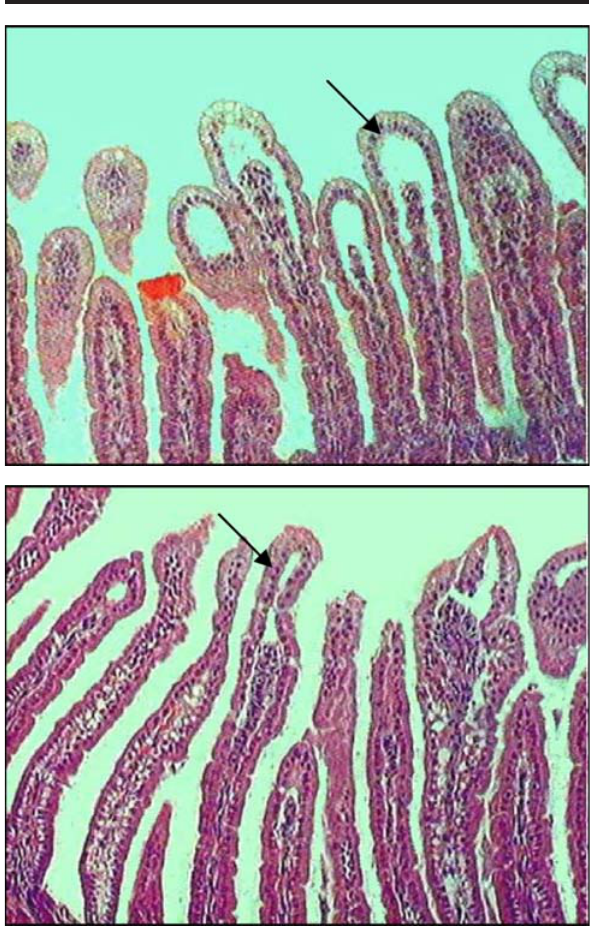
FIGURA 2 - Fotomicrografia de corte histológico de intestino do animal do Grupo Controle mostrando mucosa com vilosidades bem constituídas, sem lise celular ou processo infamatório, porém, com formação do espaço subepitelial de Grunhagen- seta preta (grau 1).